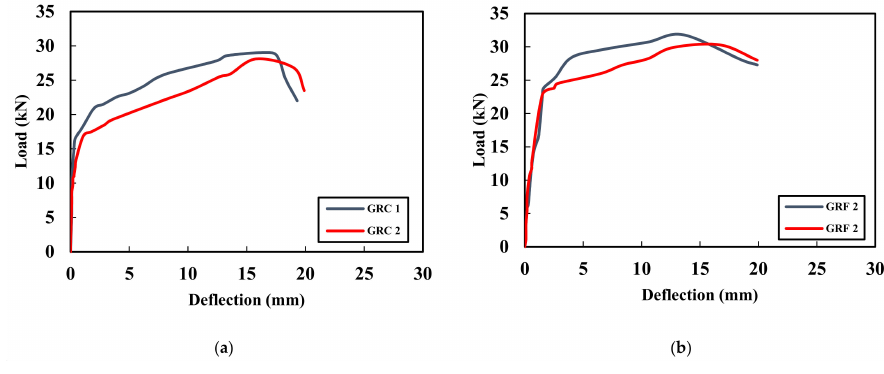
Figure 8. Load–deflection behavior of ( a ) GRC and ( b ) GRF.